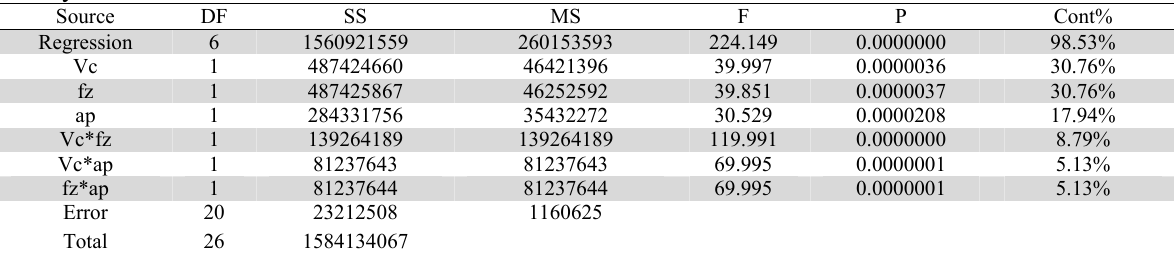
Analysis of variance for Material Removed Rate Source DF SS MS F